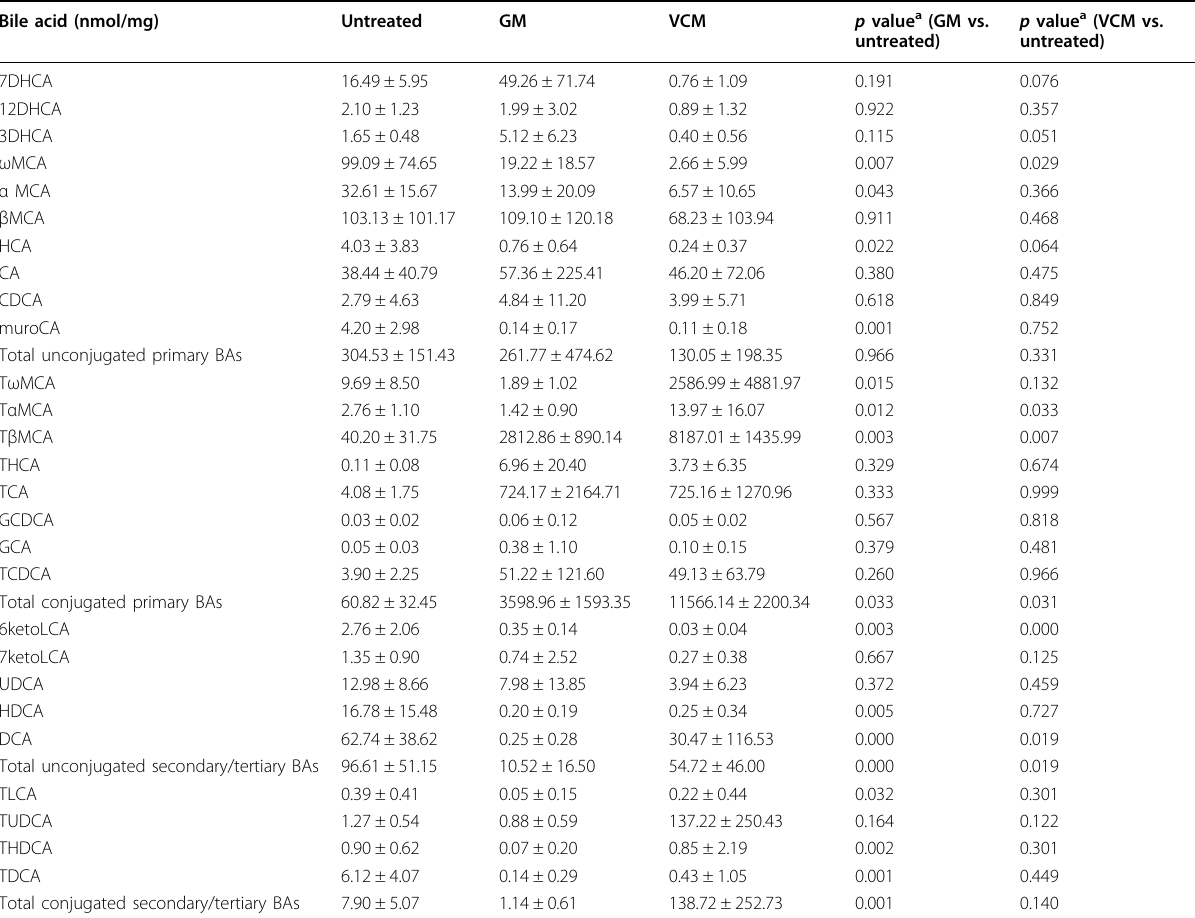
Table 2 Bile acid pro fi les in the colonic content of mice (nmol/mg) Bile acid